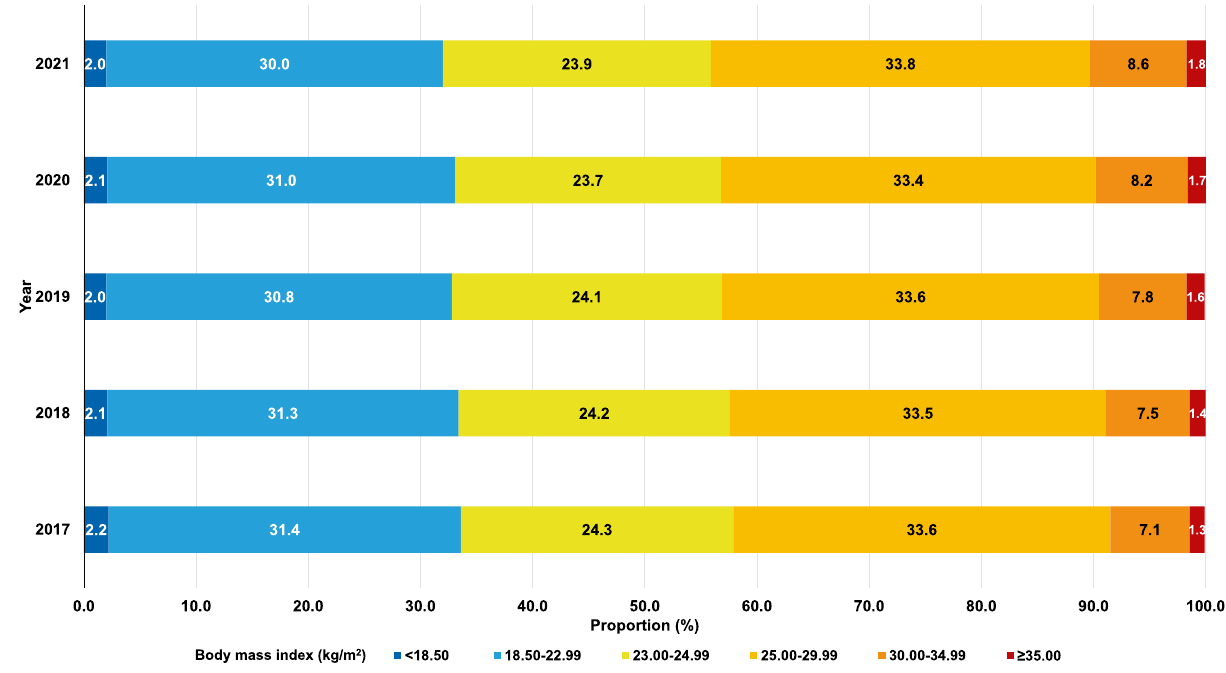
Figure 1. Proportion of BMI groups among RTA personnel from 2017 to 2021.